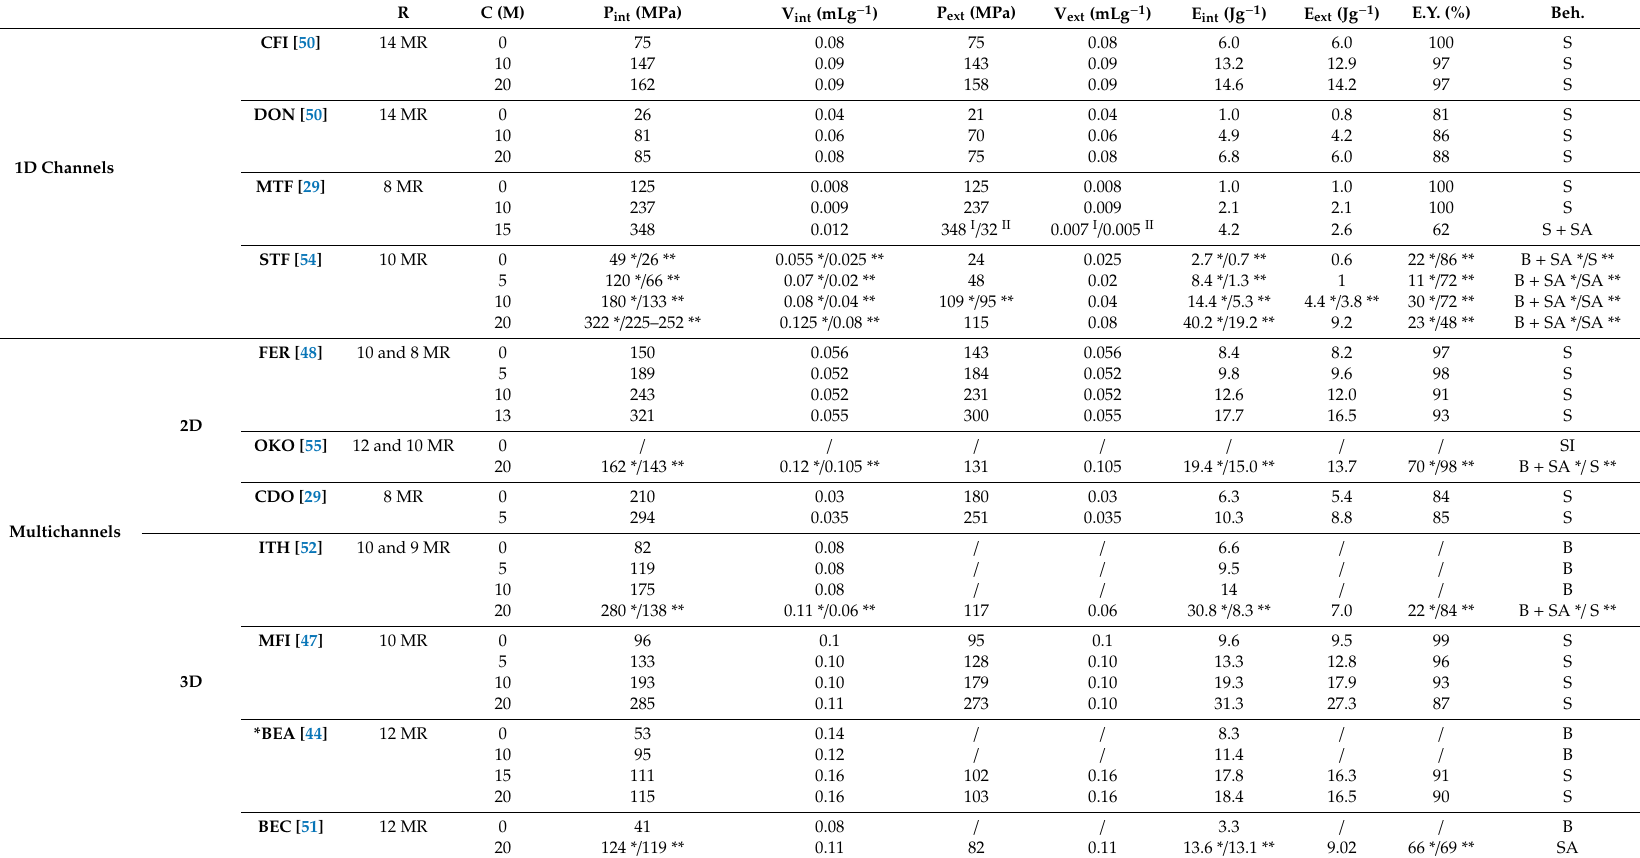
Table 2. Intrusion–extrusion features of zeosils under intrusion of water (0 M) and LiCl aqueous solutions. Zeosils framework types are reported specifying their porosities size R in terms of ring type (i.e., the number of T atoms constituting the ring). The following parameters are also reported: LiCl aqueous solution concentration (C.), intrusion pressure (P int ), intruded volume (V int ), extrusion pressure (P ext ), extruded volume (V ext ), absorbed (E s = V int × P int ) and restored (E r = V ext × P ext ) energies, energy yield (E.Y.) (Energy yield = E r / E s × 100%), and the behavior type (SI = Spontaneus Intrusion, S = Spring, SA = Shock Absorber, B =